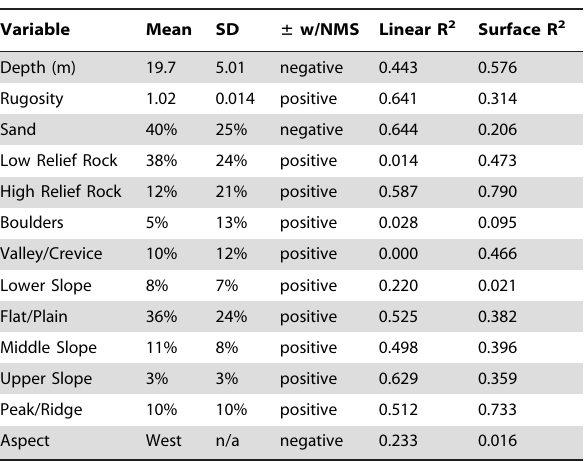
Table 2. Mean and standard deviation for habitat variables within hydrophone buffers and maximum linear and contour (surface) correlations (R 2 ) of the habitat variables with the NMS ordination